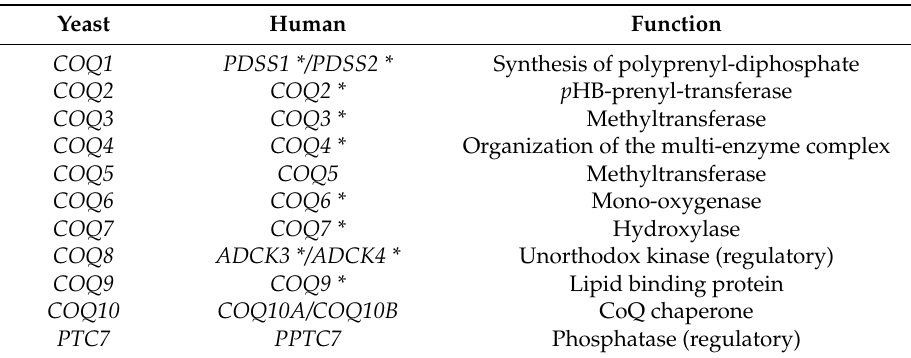
Table 1. Yeast COQ genes and their characterized human